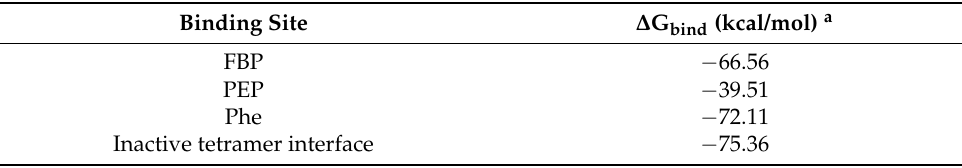
Table 2. The binding energies of compound 1 in different binding sites.